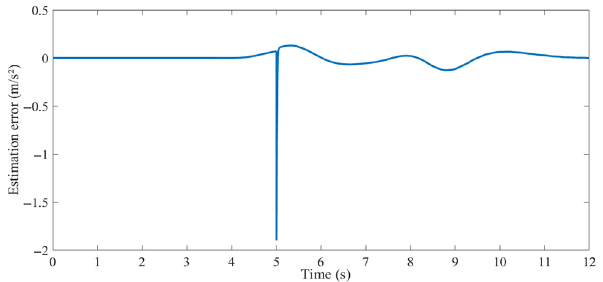
Figure 19 Fault estimation error curve of the lateral acceleration sensor by estimation method in this paper